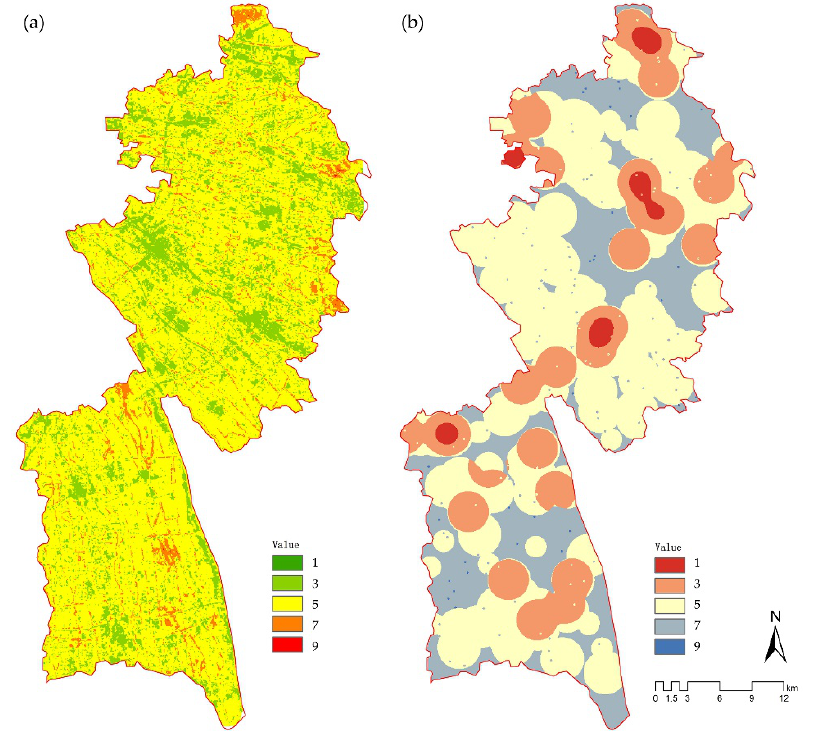
Figure 4. Ecology and recreation spatial pattern: ( a ) importance evaluation of ecological protection; and ( b ) suitability evaluation of recreational space.